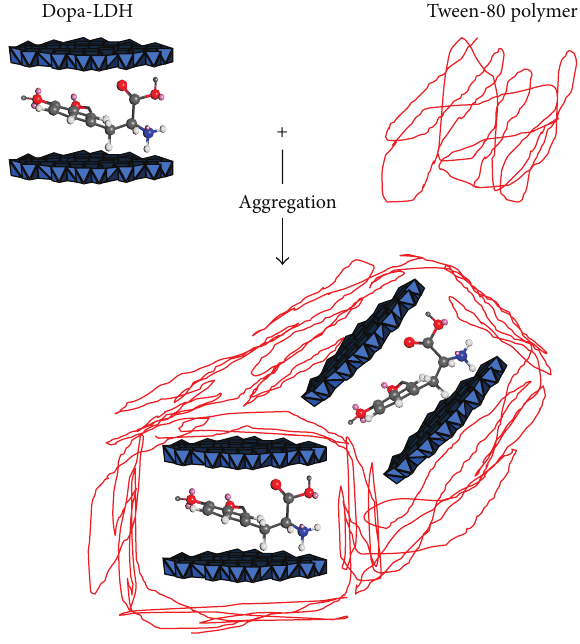
Figure 2: Schematic representation of the aggregation type of nanocomposite produce from the interaction between dopa-LDH nanocomposite and Tween-80